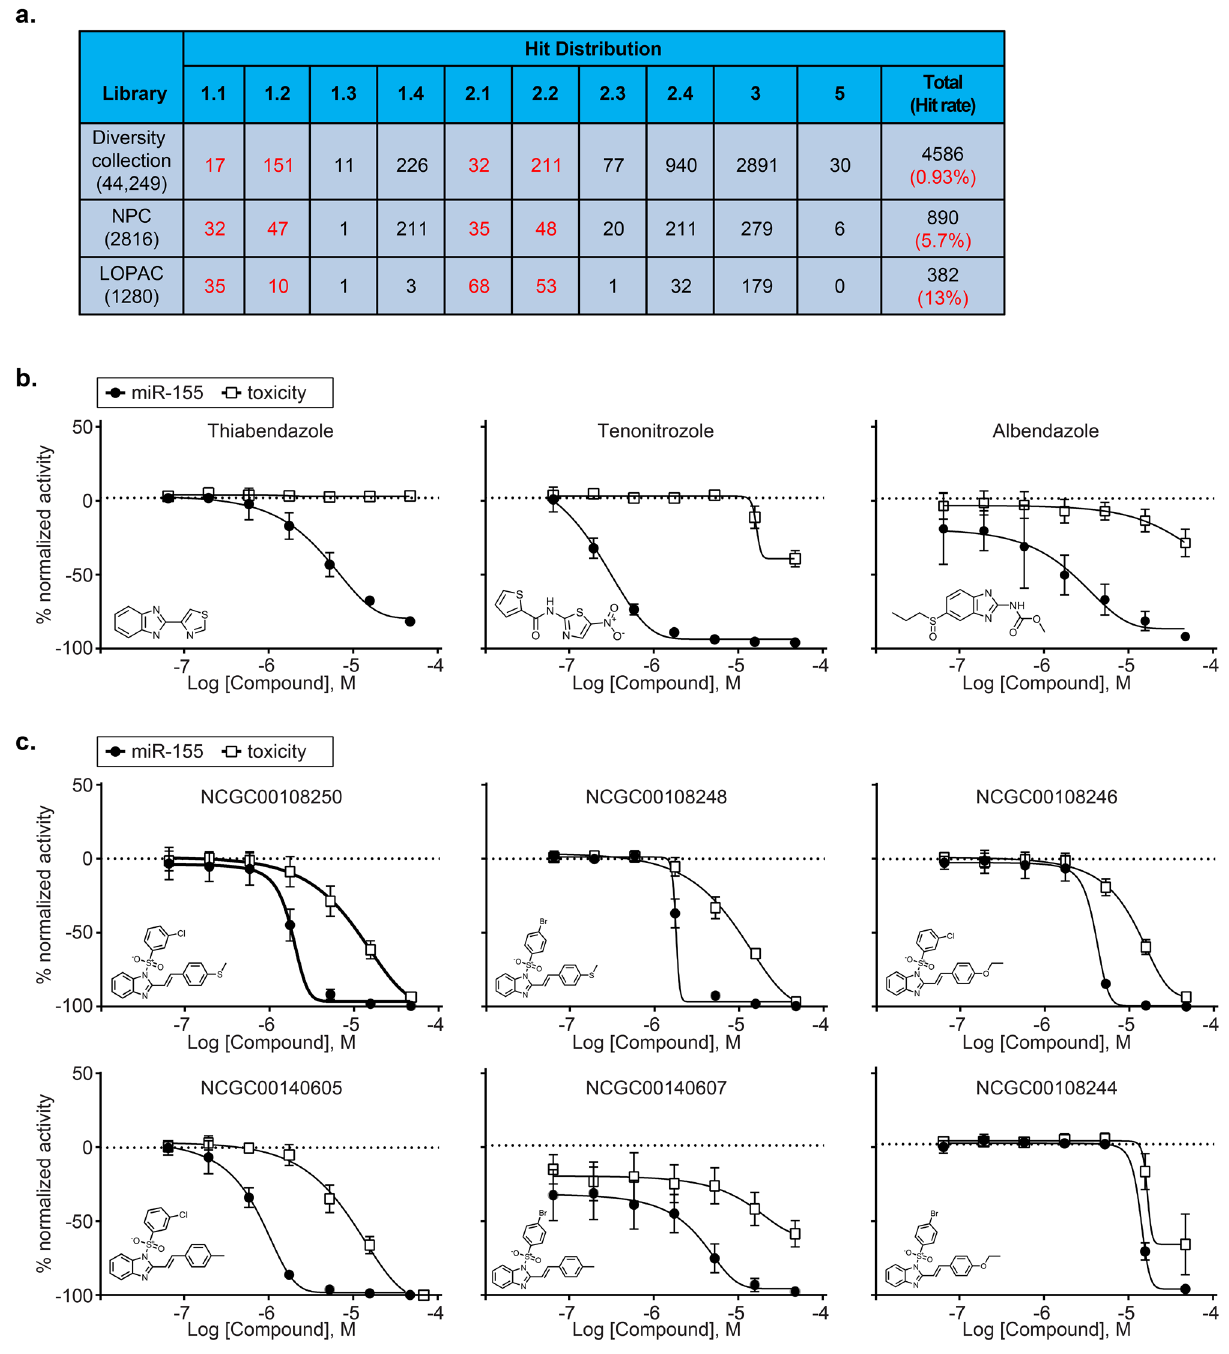
Figure 2. HTS screening to find inhibitors of Mir155 reporter expression. ( a ) Table depicting distribution of hit compounds (inhibitors) among various curve classes after small molecule screening of FDA approved drugs, Diversity Collection and the LOPAC collection. ( b ) Dose response curves for the indicated hit compounds (from screening of FDA approved library) for β-gal signal and cell viability using CellTiter-Glo. Th17 cells from Mir155 reporter mice were used for the assay. The data is from hit confirmation studies testing 7 doses (top concentration 46 µM; 1:3 dilutions thereafter). ( c ) Dose response curves for the indicated compounds (from screening of Diversity Collection) for β-gal signal and cell viability using CellTiter-Glo. Th17 cells from Mir155 reporter mice were used for the assay. The data is from hit confirmation studies testing 7 doses (top concentration 46 µM; 1:3 dilutions thereafter). Data in panels ( b , c ) are representative of at least 3 independent experiments and the error bars indicate standard